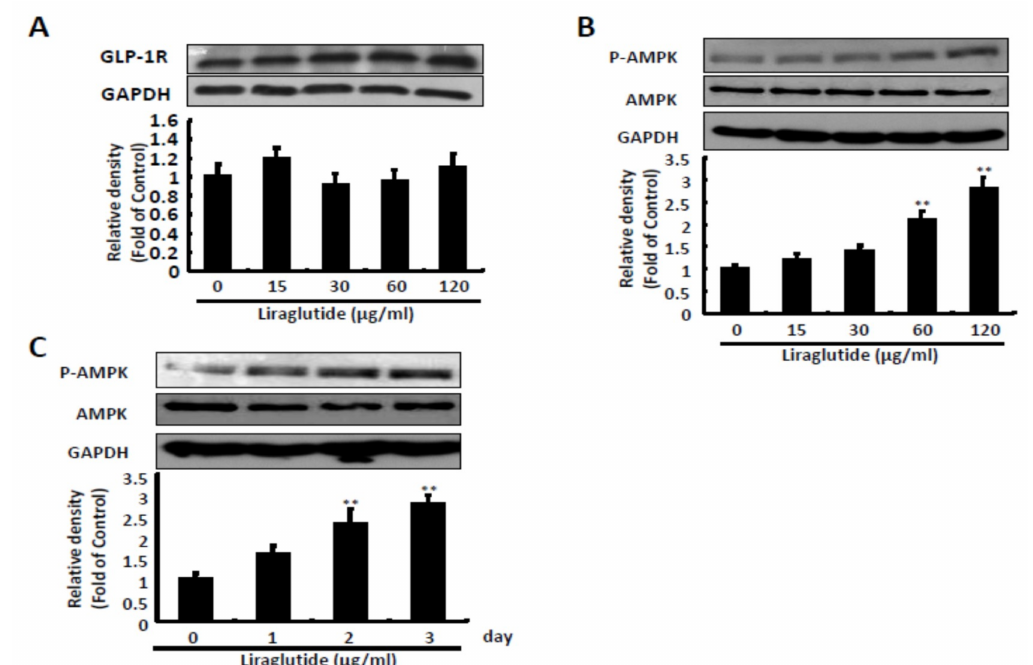
Figure 2. E ff ects of liraglutide on GLP-1 receptor expression and AMPK phosphorylation. ( A ) Liraglutide makes no significant di ff erences in GLP-1 receptor. Ava5 cells were treated with liraglutide with indicated concentrations for three days. The cell lysate was extracted and the protein synthesis was analyzed by Western blot by using anti-GLP-1R and anti-GAPDH (loading control) antibodies. ( B , C ) Liraglutide activated AMPK phosphorylation in a concentration- and time-dependent manner. Ava5 cells were treated with liraglutide with e ff ective antiviral concentrations for 3 days or 120 µ g / mL of liraglutide in di ff erent lengths of time (1, 2, and 3 days). The cell lysate was extracted and the protein synthesis was analyzed by Western blot using anti-AMPK, anti-phospho-AMPK, and anti-GAPDH (loading control) antibodies. The relative densities of bands are quantified and showed below the Western images. The results shown are presented as the percentage ± standard deviations (SD) from three independent experiments. ** p < 0.01, as assessed using the Student’s t -test for quantification of relative band intensity from each individual experiment and